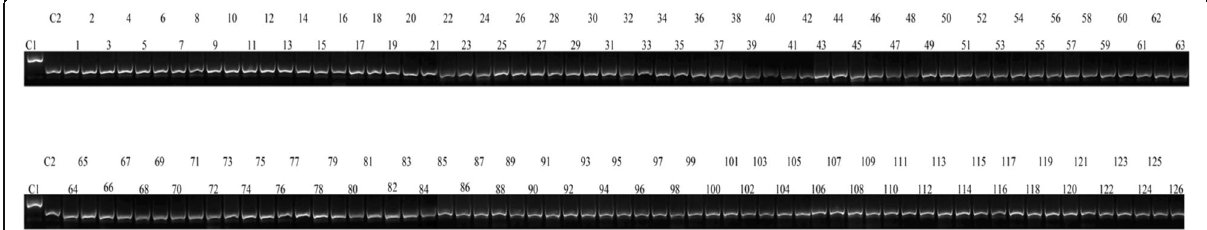
Fig. 2 Linkage analysis of R gene in IR64 to 9475-1-3 with Pita2 diagnosed CAPS marker (18729F3/R4- PvuII). F2 progeny derived from a cross between IR64 and CO39 were inoculated with 9475-1-3 and 126 susceptible lines were selected for linkage analysis. C1: IR64. C2: CO39. The CAPS marker has PvuII cleavage site on CO39 sequence. The product amplified by 18729F3/R4 from CO39 is 825 bp in size. After. PvuII cleavage, the products are 416 bp and 409 bp in